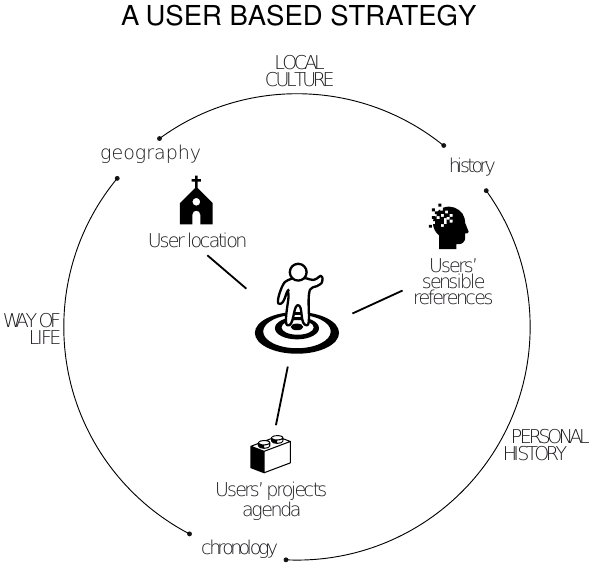
Figure 1. The service design methodology: a user based